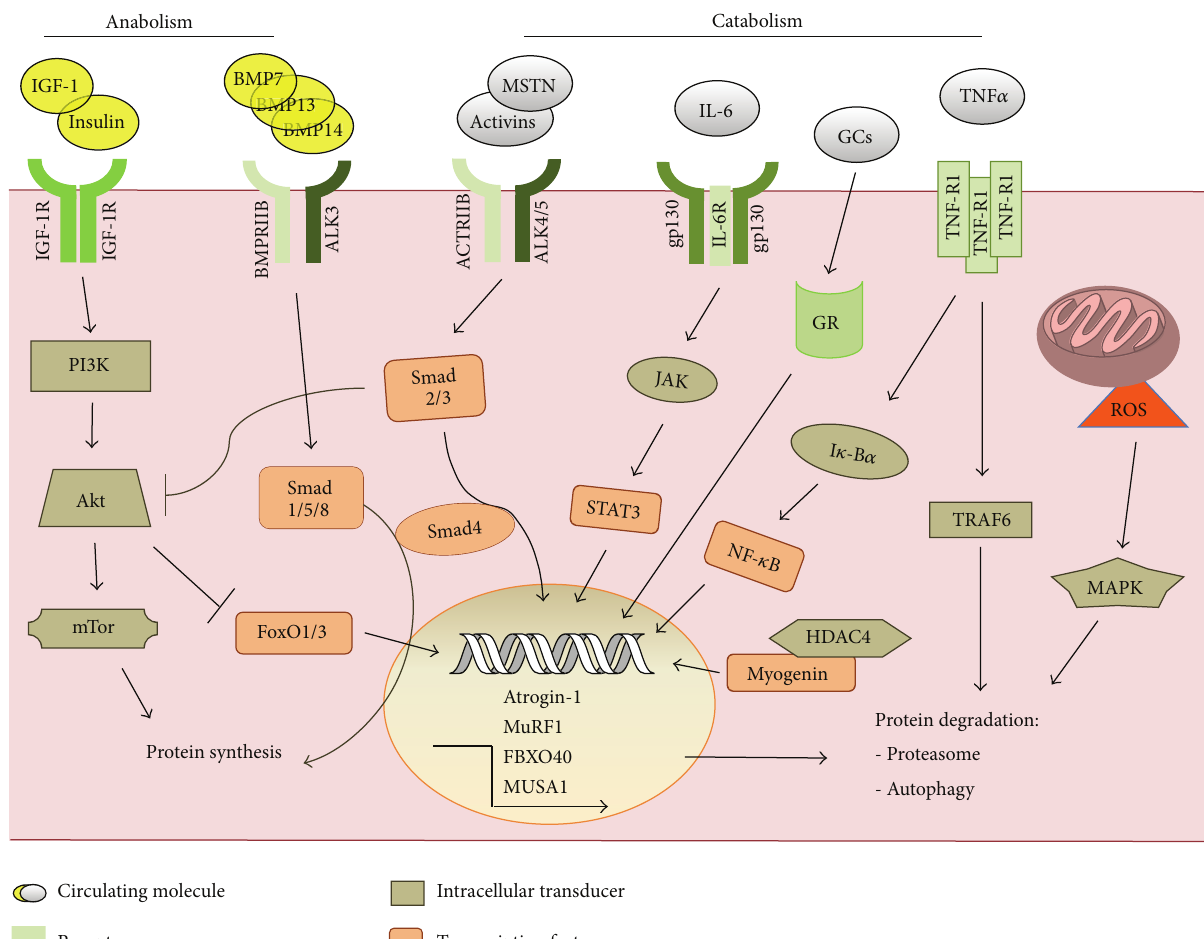
Figure 1: Humoral mediators and associated pathways drive anabolic and catabolic responses in the skeletal